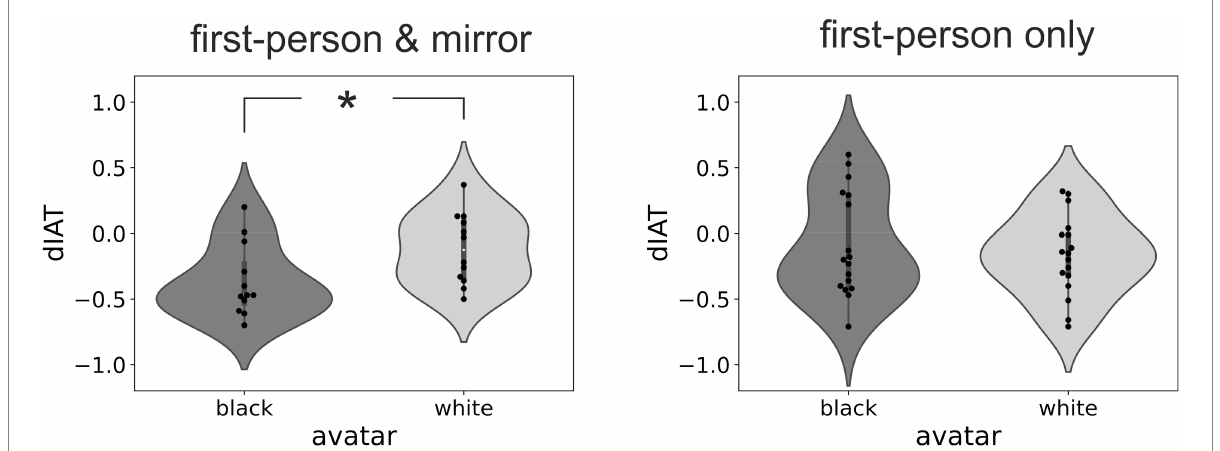
FIGURE 2 Changes in IAT scores – In all panels the black dots represent the individual differences in IAT scores (dIAT) after and before virtual embodiment for the Black (dark gray bar) and White (light gray bar) avatar. The left panel shows results for participants that could see their virtual bodies both from a first-person perspective and in a mirror, while the right panel shows results for participants that could see their virtual body only from a first-person perspective. The thick vertical bars represent the first and third quantiles and the white dots the median of the distribution. Significant differences are highlighted by an asterisk (*).